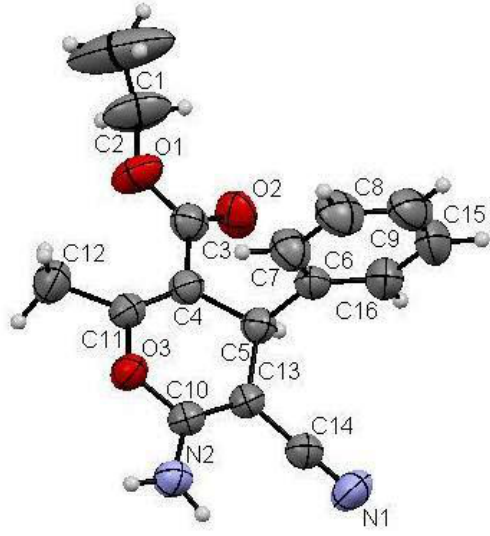
Figure 2. X-ray crystal structure of ( R )-5-acetyl-2-amino-6-methyl-4-phenyl-4 H -pyran-3- carbonitrile ( 6b ).